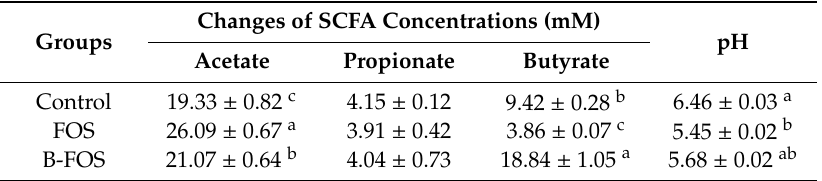
Table 3. Changes in short-chain fatty acid (SCFA) production and pH by 24 h anaerobic